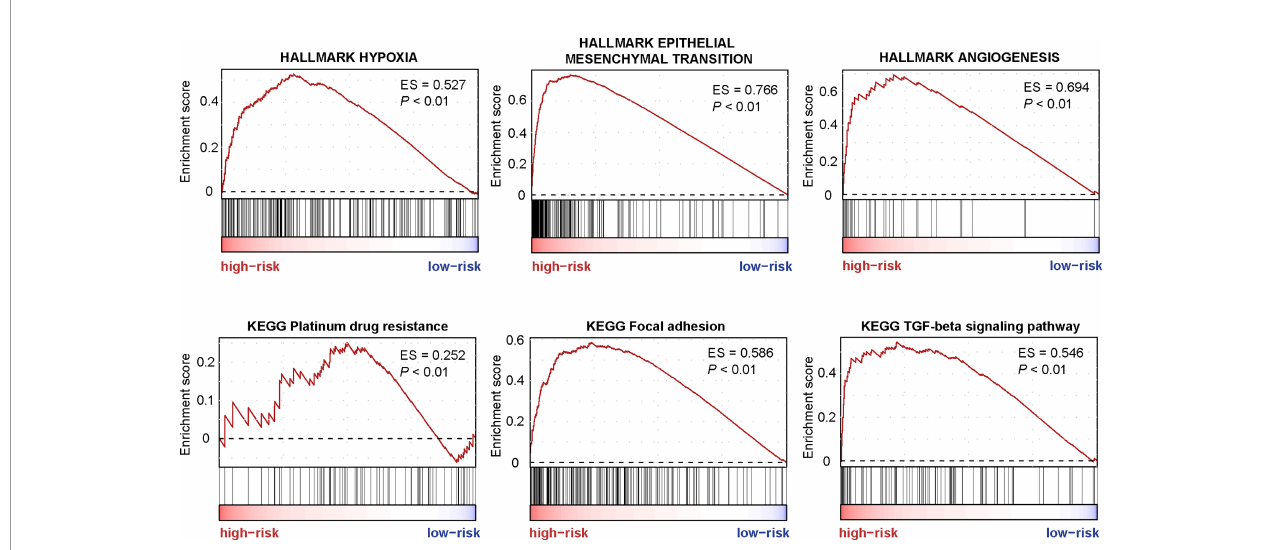
FIGURE 6 | The enriched pathways are associated with the TF-9 signature. GSEA revealed that these nine transcription factor genes are mainly related to hallmark gene sets of EMT, hypoxia, angiogenesis, Platinum drug resistance, focal adhesion, and the TGF-beta signaling pathway.